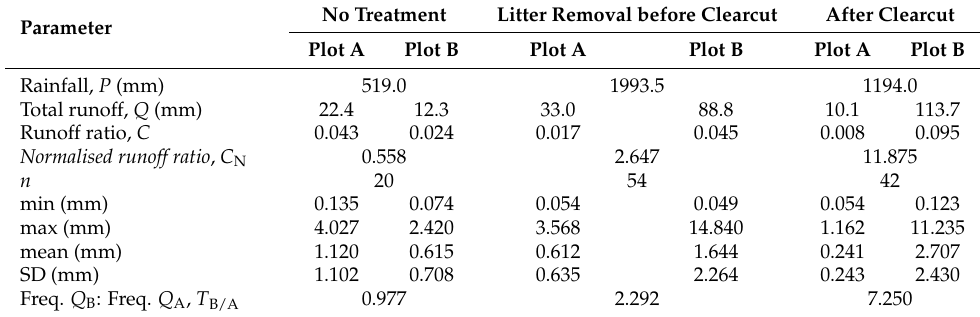
Figure 6. Monthly runoff in plot A, B and precipitation in the different phases. Table 1. General statistics in the NT, LRBC, and AC